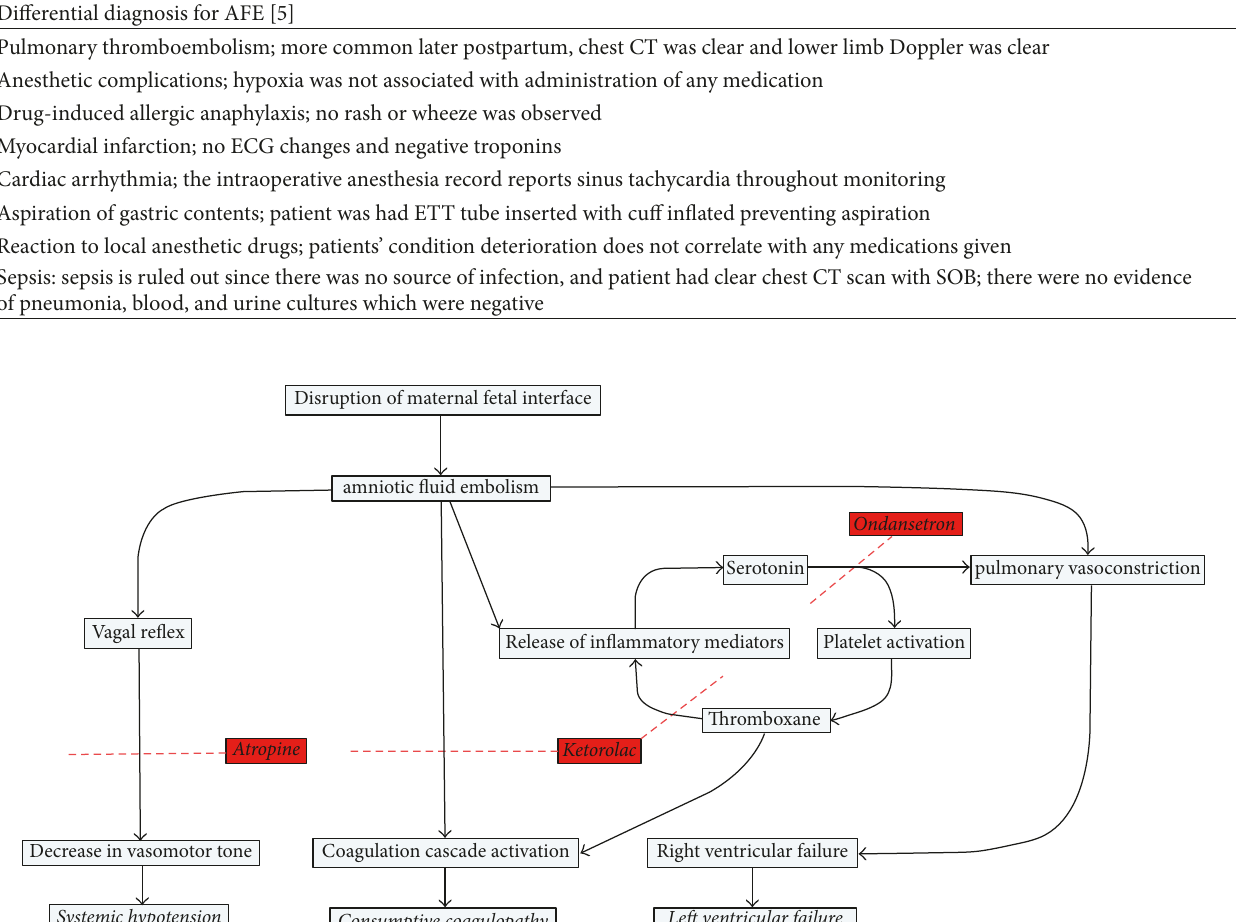
Differential diagnosis for AFE [5]